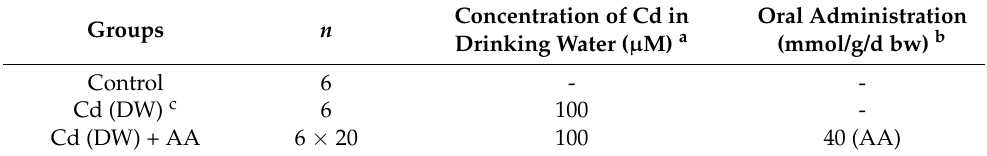
Table 1. Primary experimental protocol of Cd-exposed mice treated with amino